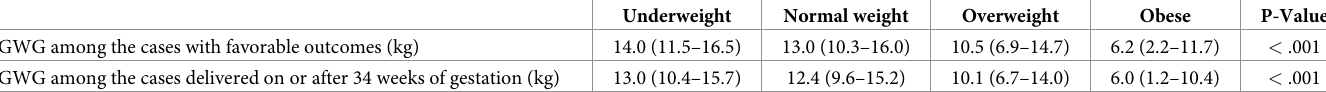
Table 2. Gestational weight gain among the cases with both babies appropriate for gestational